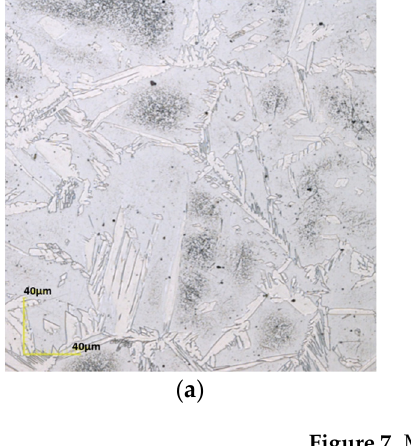
Figure 7. Microstructure observed in the HAZ of the as welded condition sample: ( a ) edge; ( b ) 1/4 region; ( c ) 1/2 region.